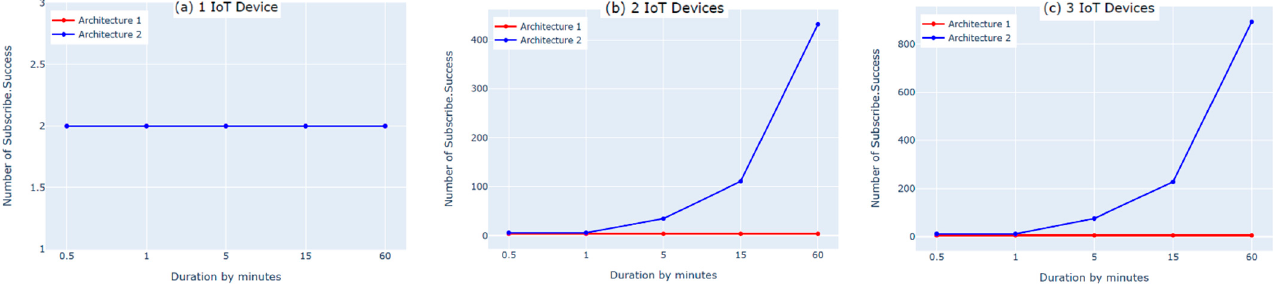
Figure 9. AWS IoT message broker Subscribe Success metrics with 1, 2, and 3 IoT devices on the North Virginia datacenter (cloud layer).